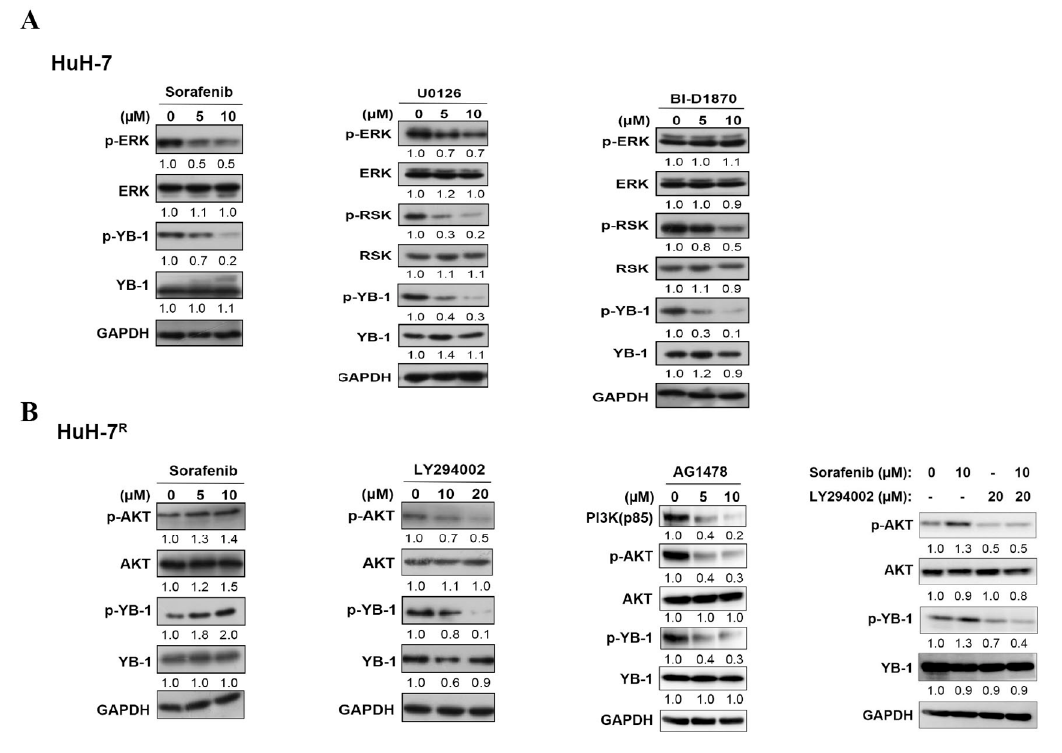
Figure 2. YB-1 phosphorylation is regulated by different signaling pathways in response to sorafenib treatment in HuH-7 and HuH-7 R cells. ( A ) HuH-7 cells were incubated with increasing doses of sorafenib, U0126 or BI-D1870 for 12 h. ( B ) HuH-7 R cells were incubated with increasing doses of sorafenib, LY294002, AG1478 or sorafenib combined with LY294002 for 12 h. Cell lysates were separated using sodium dodecyl sulfate-polyacrylamide gel electrophoresis (SDS-PAGE) and subjected to immunoblotting with the indicated antibodies. Intensity was quantified using densitometry and normalized to that of GAPDH. Blots are representatives of three separate experiments.